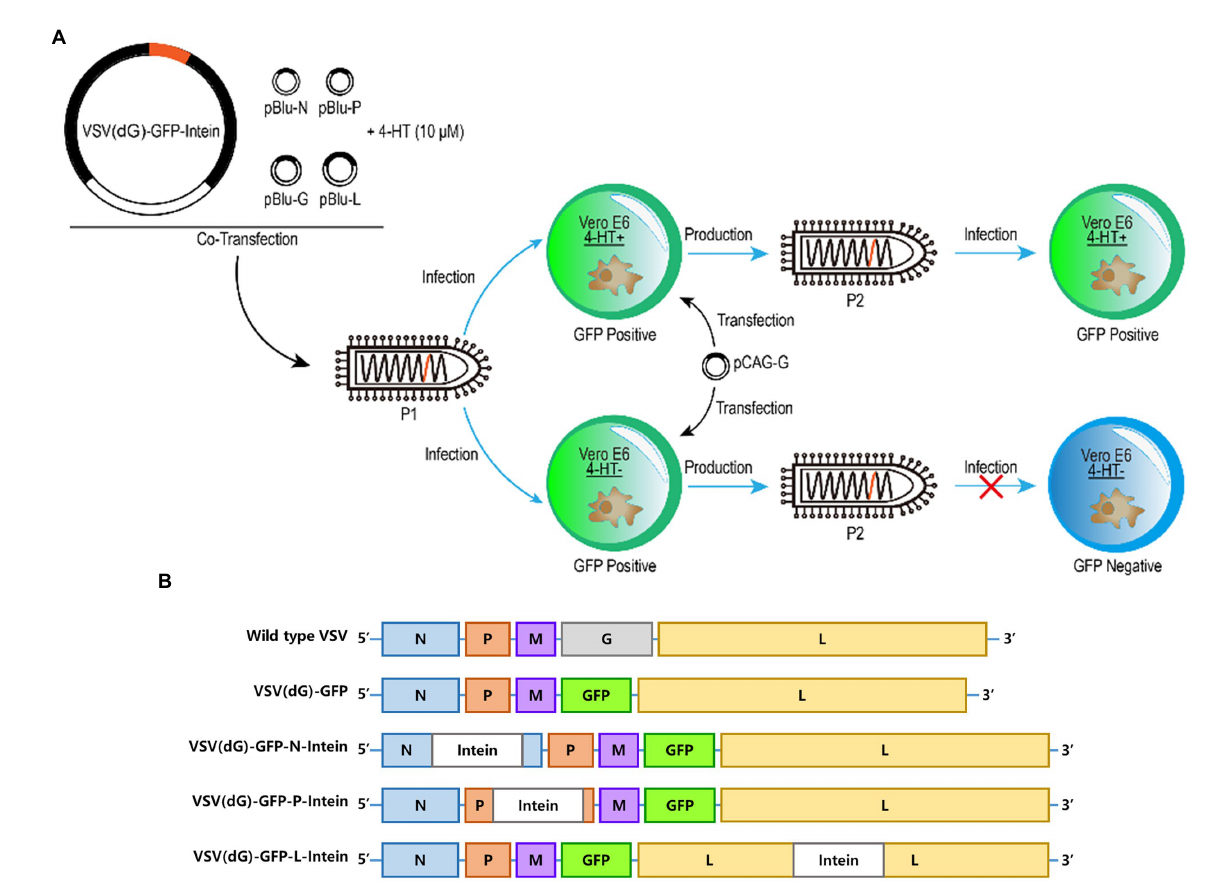
FIGURE 1 Experimental design and plasmids construction. (A) Schematic representation of the generation of recombinant 4-HT-regulated VSV that are characterized by high reproduction in 4-HT + media but replication incompetence in 4-HT − media. Moreover, the replication capacity was assayed by measuring the GFP expression of VSV (P2). (B) Virus genome schemes of VSV: wild type VSV, VSV (dG)-GFP, VSV (dG)-GFP-N-intein, VSV (dG)-GFP-P- intein, and VSV